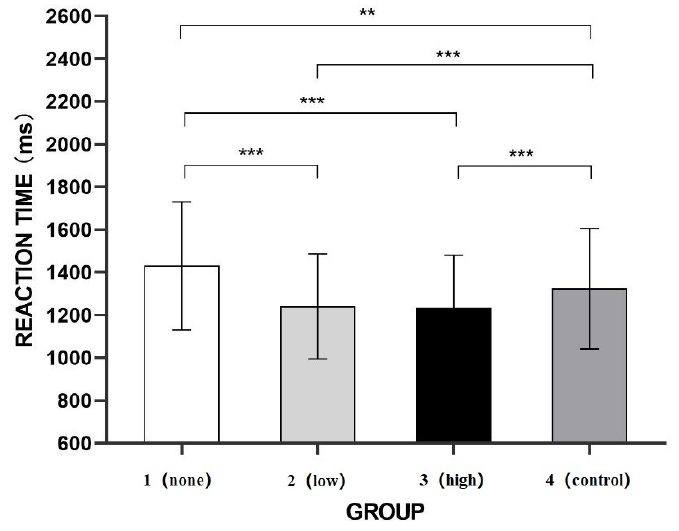
Figure 5. Reaction times to tourism scenes with different levels of greenery and black-and-white suppression images. *** p < 0.001 **, p < 0.01.